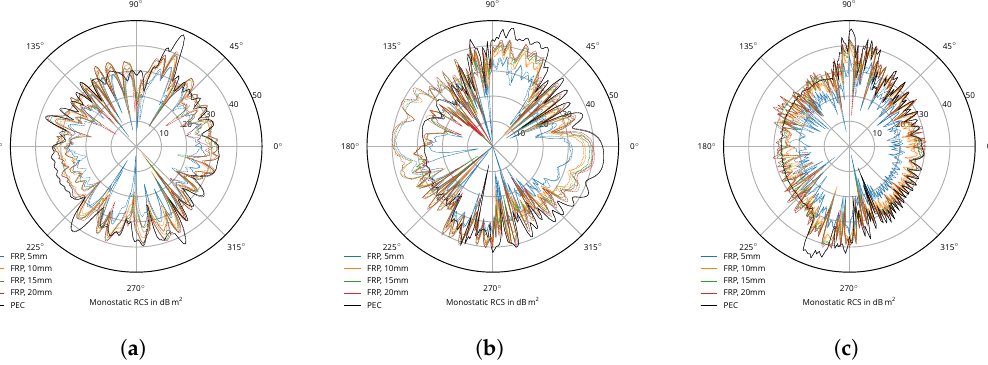
Figure 5. Monostatic RCS (in dBm 2 ) of the blades made with lossy FRP (tan δ = 0.05) of different thicknesses. Continuous lines: V polarization; dashed lines: H polarization. The introduction of material losses does not cause significant changes compared to Figure 4. ( a ) Blade v1; ( b ) blade v2; and ( c ) blade